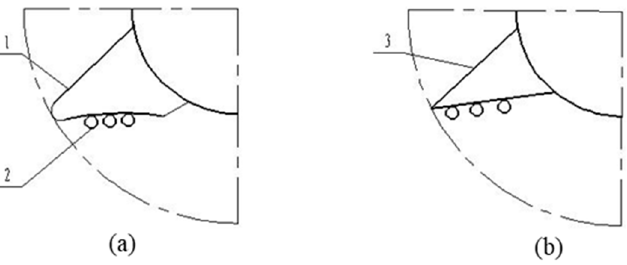
Figure 11. Schematic diagram of the two types of gear. ( a ) Curved surface gear; ( b ) Common gear; 1, Curved surface gear; 2, Hairy vetches; 3, Common gear.